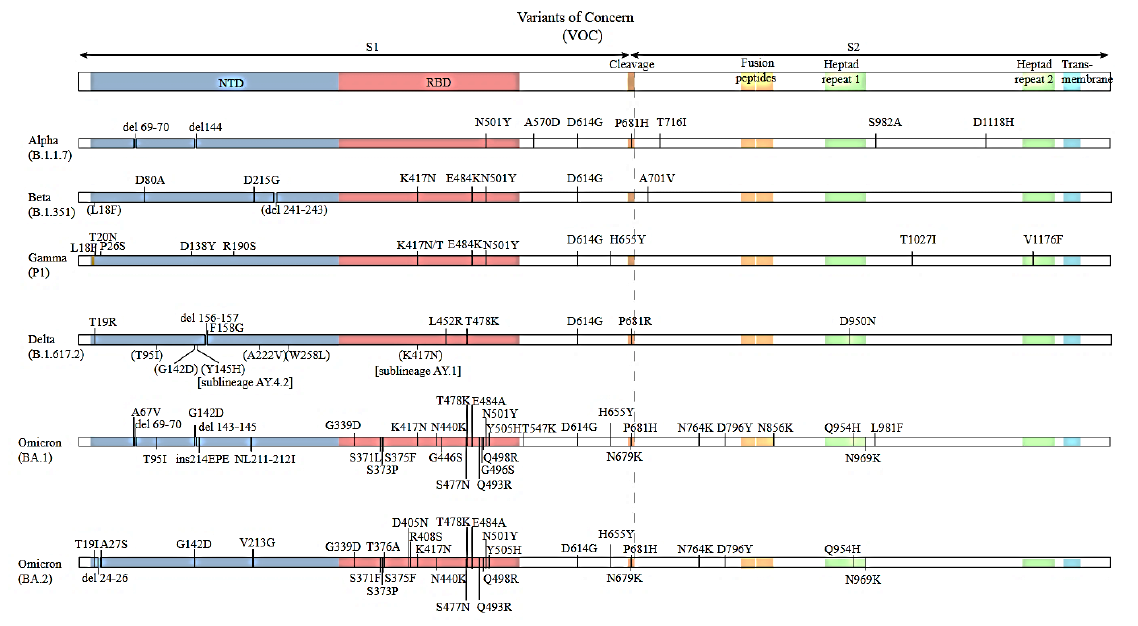
Figure 3: Variants of concerns of SARS-CoV2 overtime (Source: